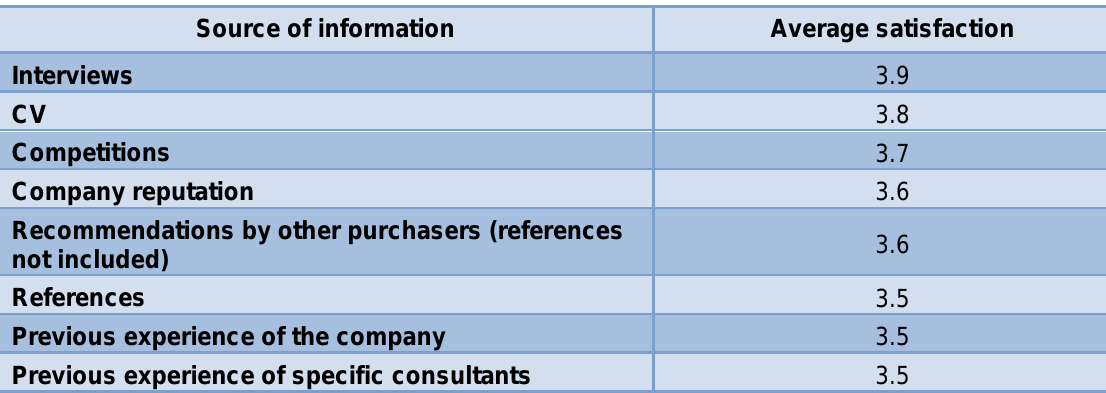
Table 9 Respondent‟s view of procurement procedures for complex projects (five-degree scale, where 1 = bad, 5 = very good) compared with respo ndent‟s use of information sources